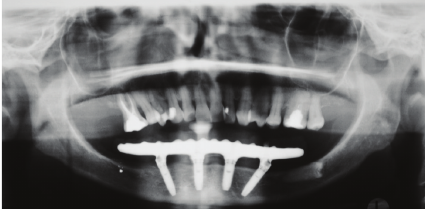
Figure 4: Orthopantomography of the patient 6 months after sur- gery.